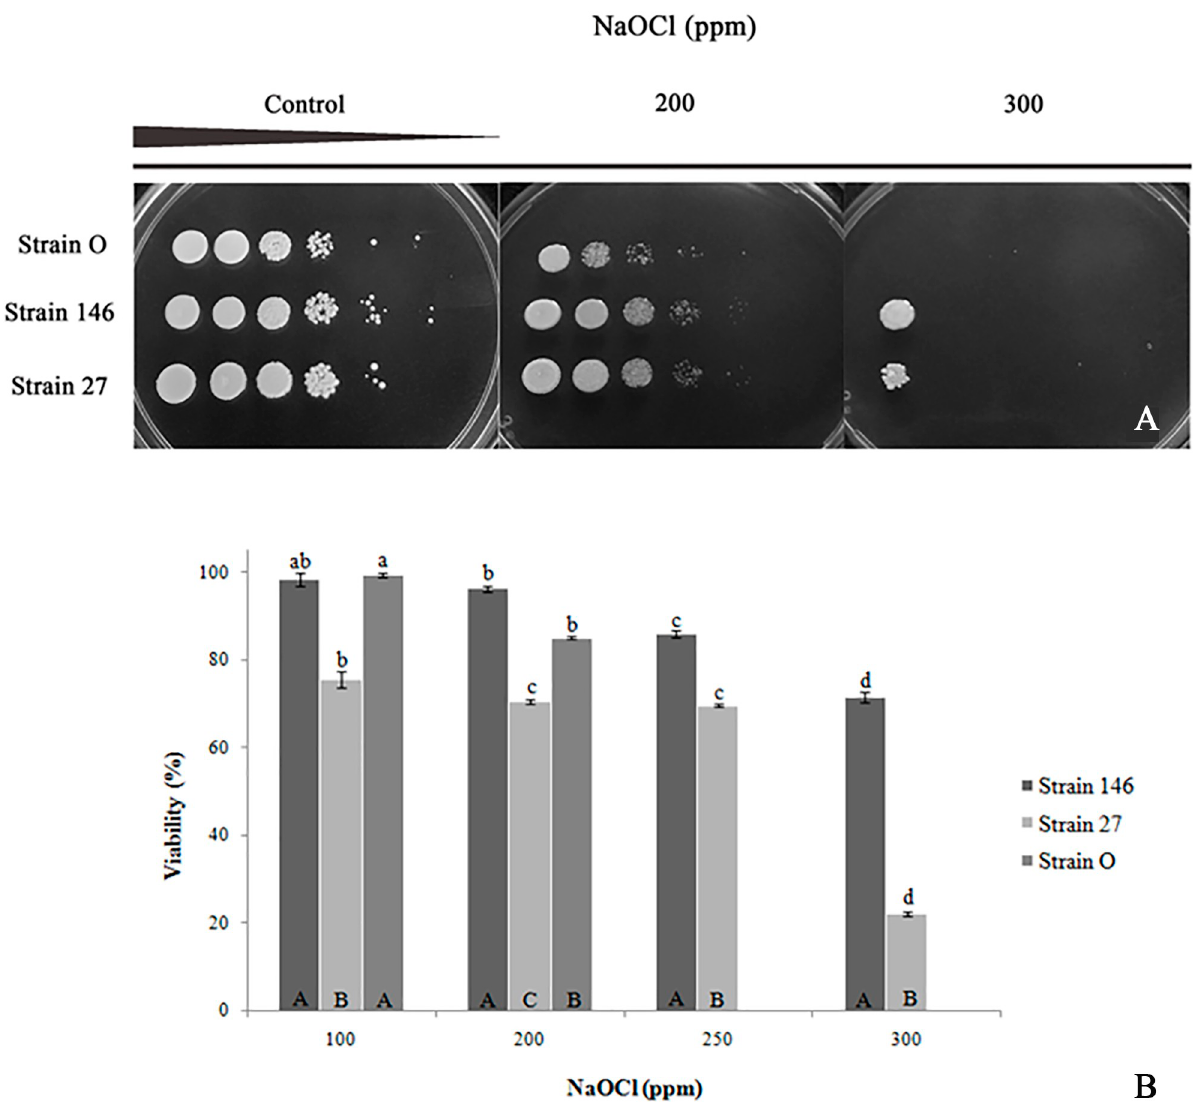
Fig 2. Effect of different NaOCl concentrations on the survival of C . lusitaniae 146, P . fermentans 27, and C . oleophila strain O. (A) The organisms were grown on YEPD liquid medium, ten-fold serially diluted and spotted onto YEPD agar plates containing above specified concentrations of the disinfectant. Growth monitoring as in Fig 1. (B) For viability assays, strains were exposed for 15 min to 100 ppm, 200 ppm, 250 ppm, 300 ppm and 400 ppm NaOCl and survival was expressed in relation to the respective untreated control. Statistic evaluation as for Fig 1. Lowercase letters again correspond to the comparison between a strain and the respective control. Uppercase letters represent comparisons between yeasts at the specific conditions.